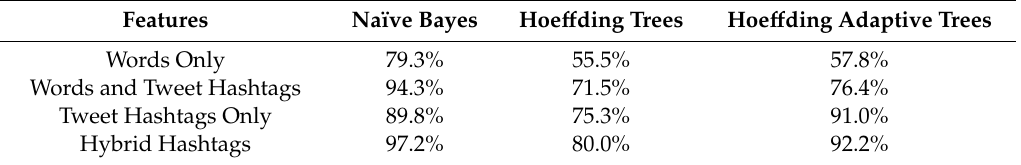
Table 5. Comparison of HHTC-Stream Tweet topic classification results with di ff erent sets of